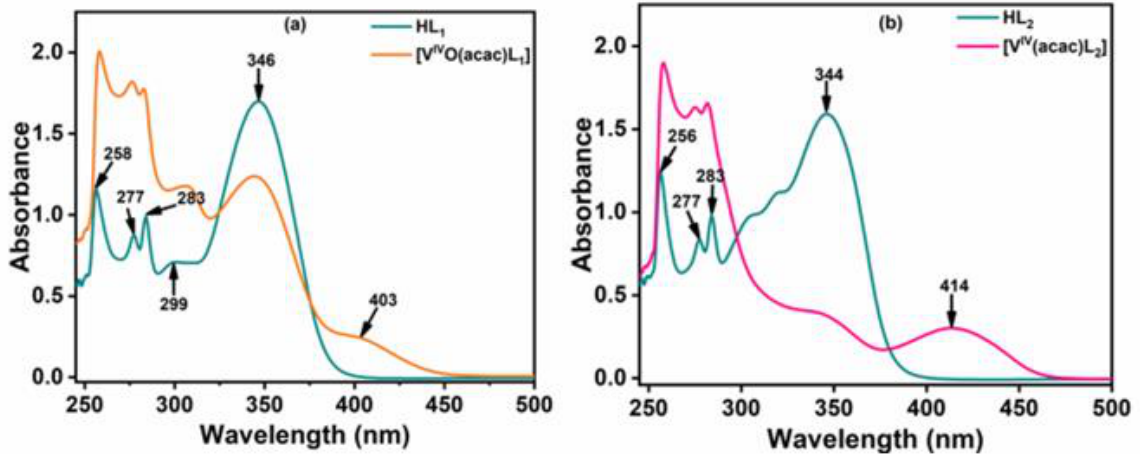
Table 1. UV-visible spectra of the ligand, homogeneous and heterogeneous complexes.